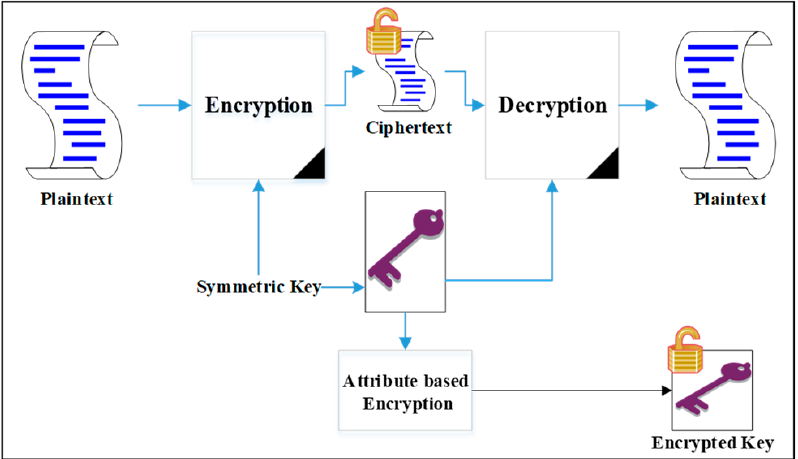
Figure 1. Using ABE to encrypt a symmetric key .